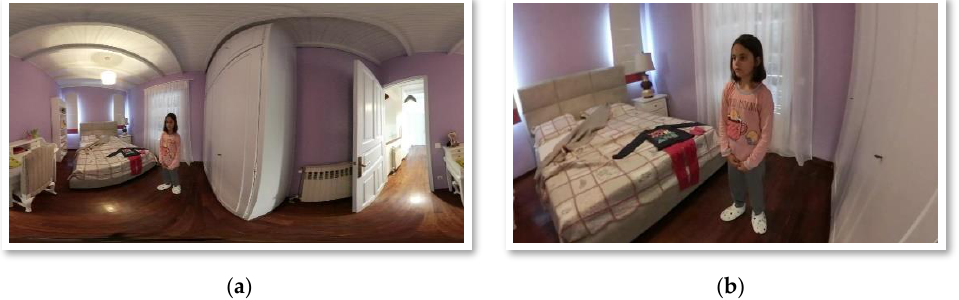
Figure 18. Post-production phase: Video converting for AR application ( a ) 360 ° video; ( b ) Standard video.